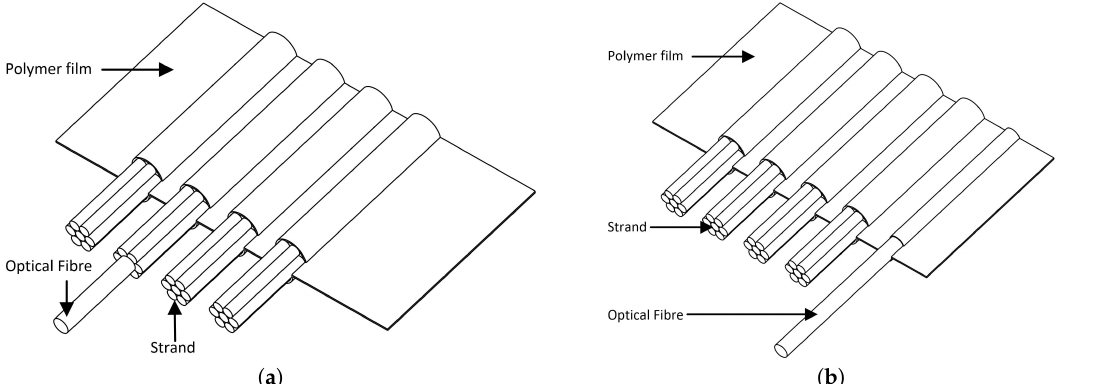
Figure 2. ( a ) Insertion of the optical sensor in a strand. ( b ) Insertion of the optical sensor between polymer